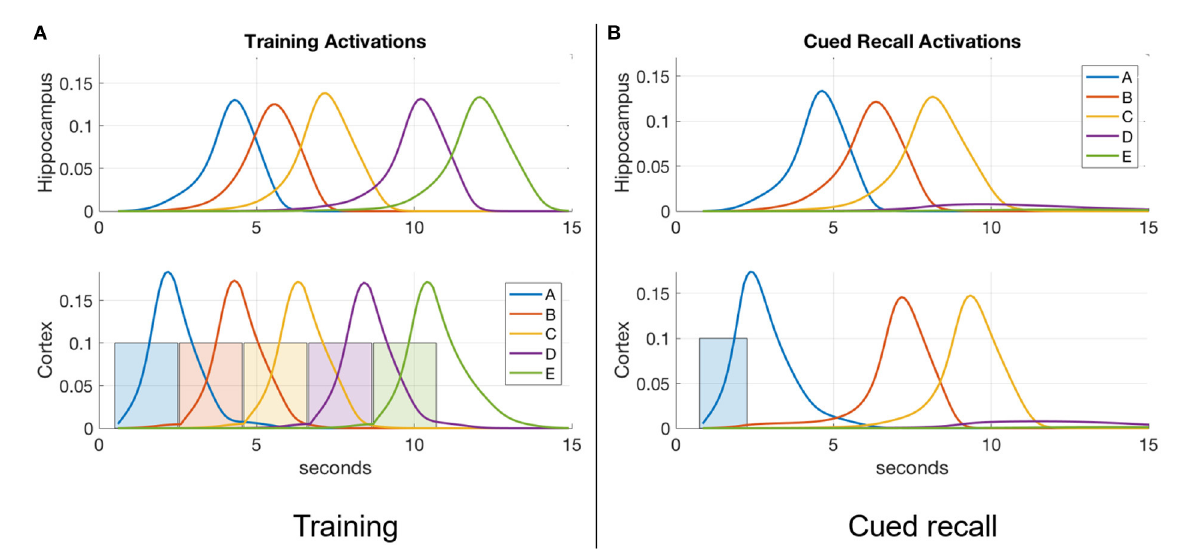
FIGURE2 An example of item activations during (A) training and (B) cued recall. (A) A five-item sequence is trained by presenting a series of inputs (the colored rectangles in cortex) that stimulate activation of matching items in cortex, and in turn activate the matching items in hippocampus. Directional excitatory projections between items within each memory module are learned as a function of their mutual activation dynamics. (B) Dynamics of neuronal activations when item “A” is cued in the input register after training. The activation of “A” in hippocampus lags behind the cued activation in cortex as cortex is driving it, but subsequent items are activated more quickly in hippocampus due to its stronger excitatory projections (owing to faster learning). In the example shown, neither module’s weights have strengthened enough to spread activation through the entire sequence, so only “A,” “B,” and “C” become activated.